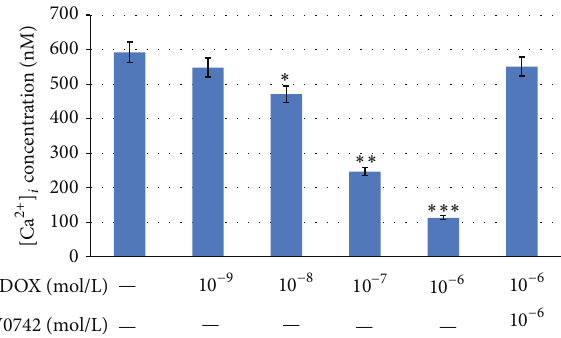
Figure 5: Effects of GW0742 on intracellular calcium release in DOX-treated neonatal rat cardiomyocytes. Changes in intracellular calcium concentration were detected by Fura-2 using a fluorescence spectrofluorometer. Cells were treated with 10 −6 mol/L GW0742 for 1 hour before incubation with 10 −6 mol/L DOX and then used for measuring intracellular calcium concentration. All values are expressed as mean ± SEM ( 𝑛 = 6 per group). ∗ 𝑃 < 0.05 , ∗∗ 𝑃 < 0.01 , and ∗∗∗ 𝑃 < 0.001 as compared with DOX-treated